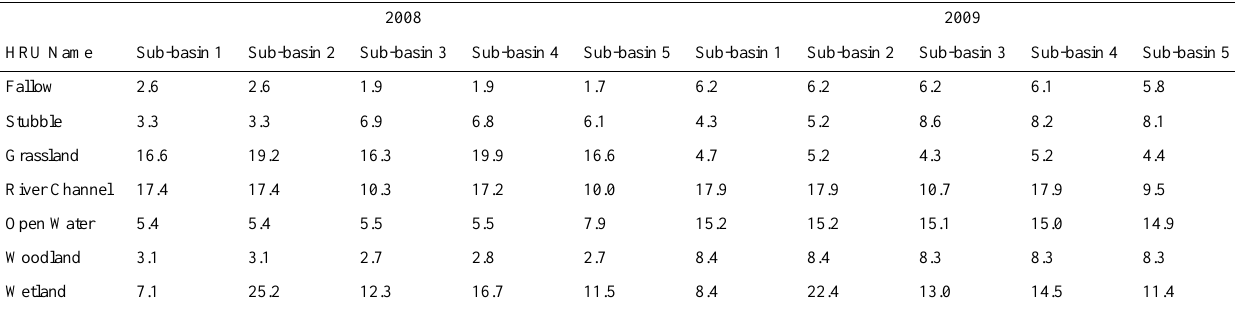
Table 2. Evaluation of snowpack simulations with the root mean square difference (RMSD, mm